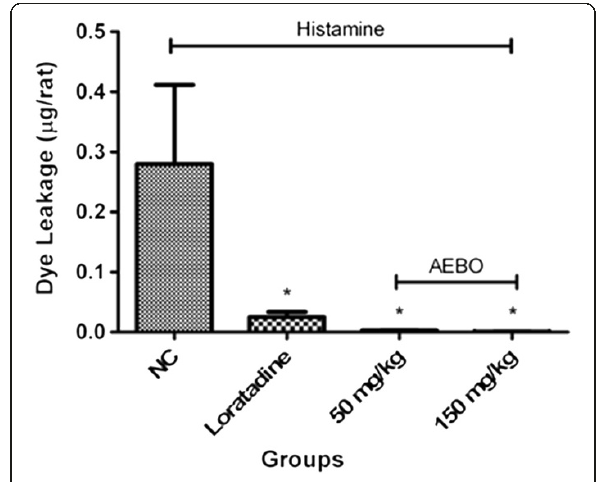
Figure 3 Effect of AEBO on histamine-induced peritoneal vascular permeability. Evans blue dye was collected and measured by spectrophotometer. Data are presented as mean ± SEM, n = 6. * P < 0.05, significantly different from NC (negative control).